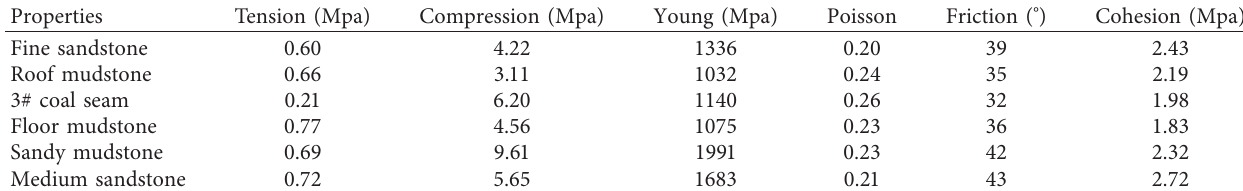
Table 2: Mechanical parameters of coal and rock